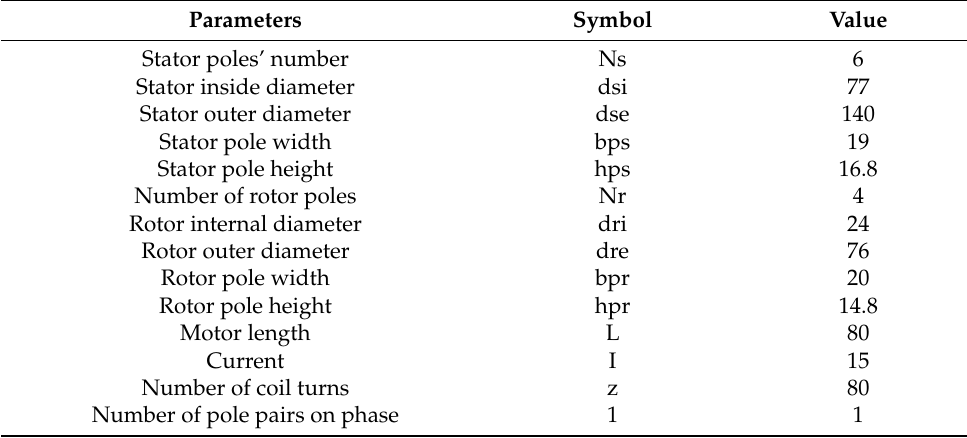
Table 2. Parameters used for model procurement of a 6/4 motor.